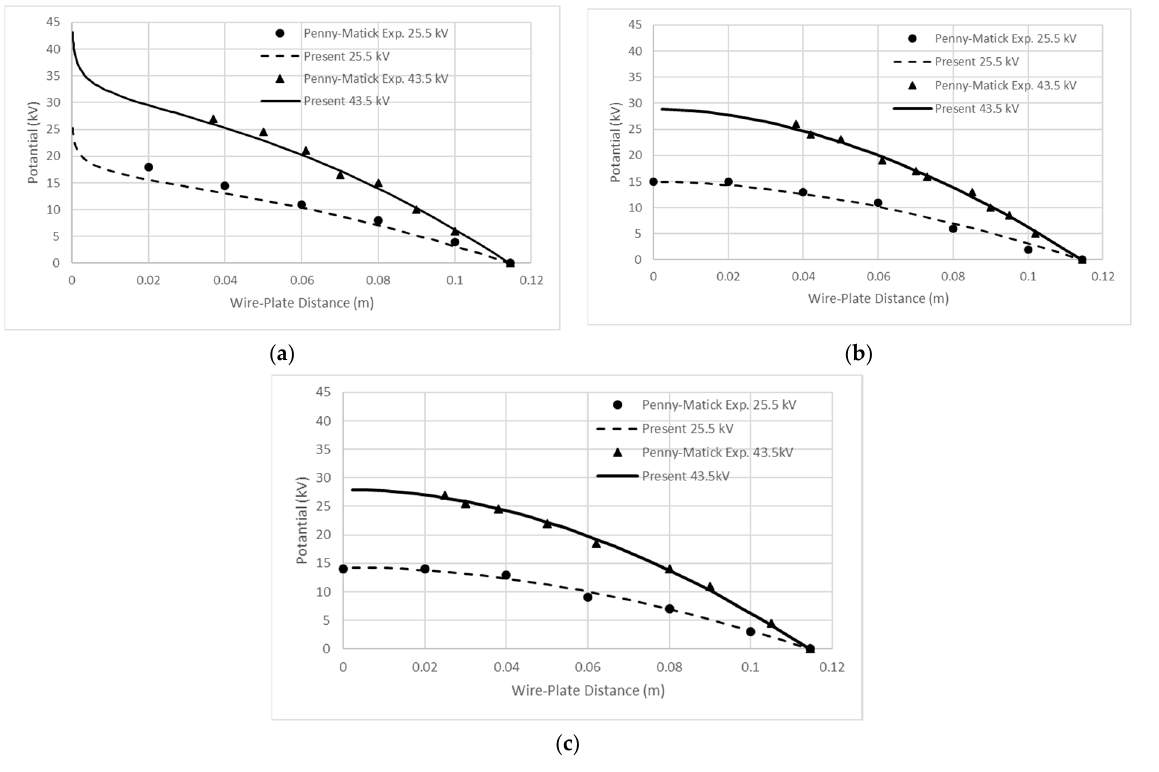
Figure 3. Comparison of electric potential values with experimental data: ( a ) at x = 228.6 mm, ( b ) at x = 266.7 mm, and ( c ) at x = 304.8 mm.